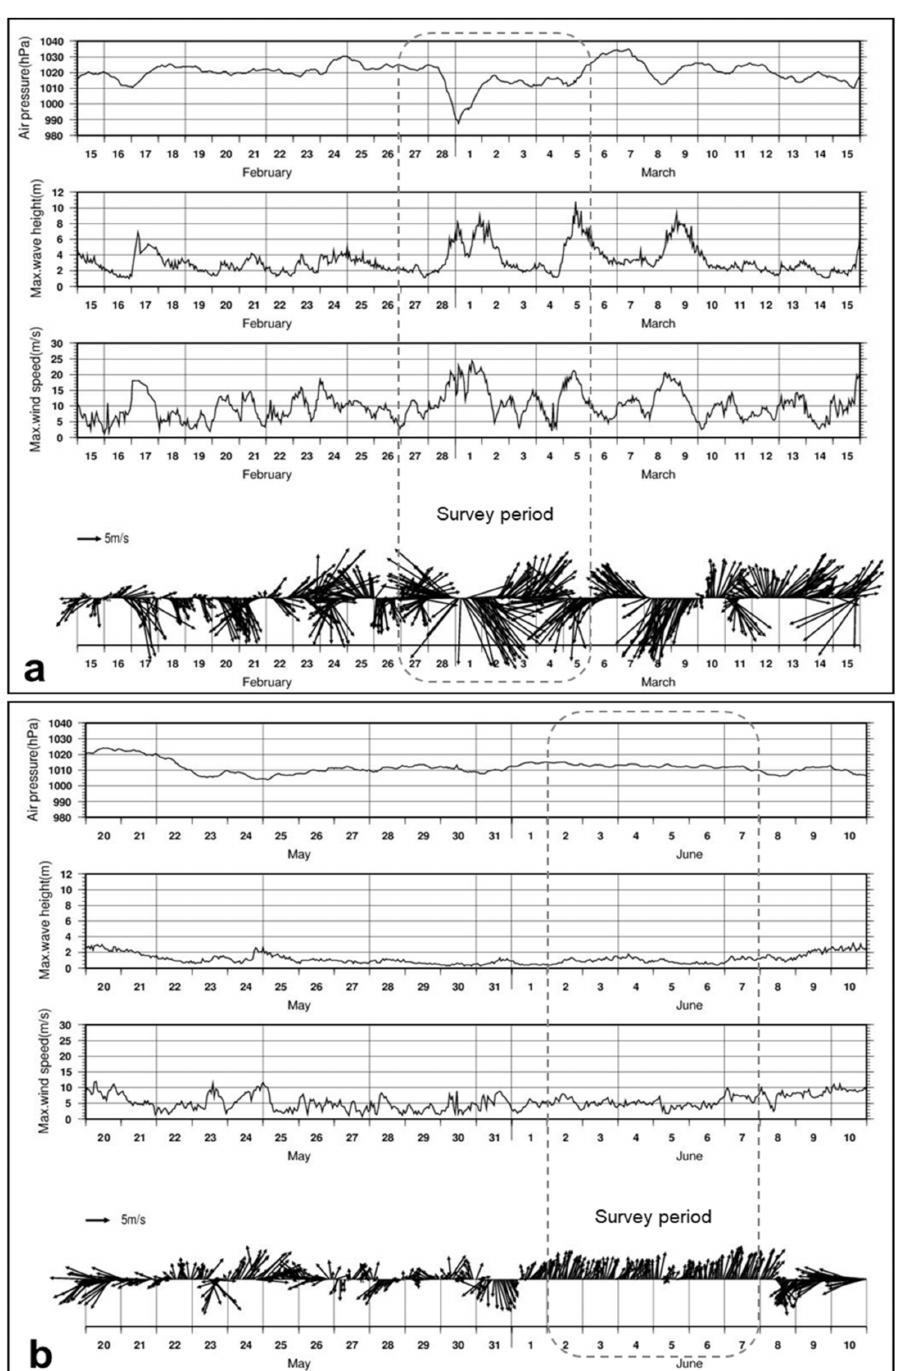
Figure 4. Time series of air pressure, maximum wave height, wind gust speed, and wind direction during February and March ( a ) and May and June ( b ) recorded by the Ulleungdo Ocean Data Buoy (Korea Meteorological